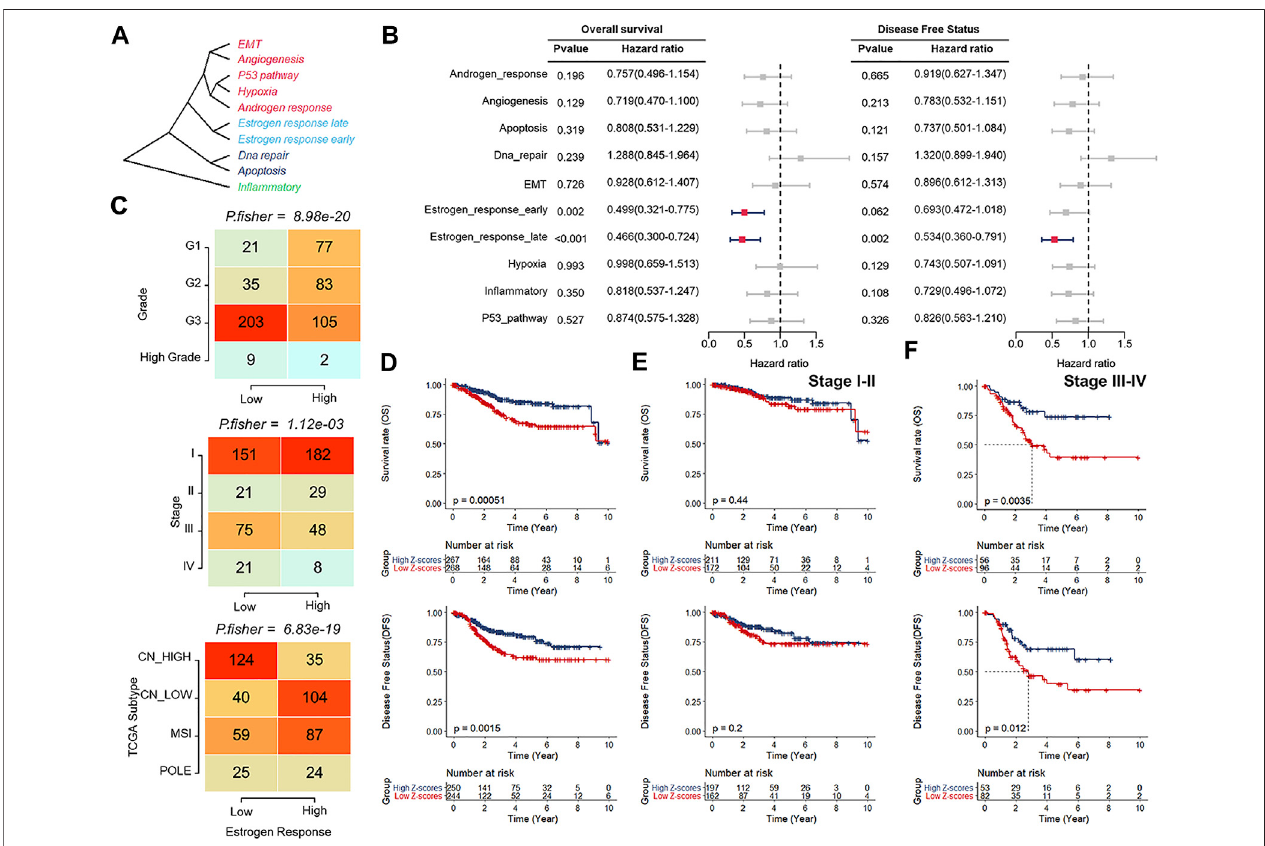
FIGURE 2 | Estrogen response pathway ssGSEA score was correlated with clinical features of patients with UCEC. (A) An unrooted clustering dendrogram depicting the distance between different hallmarks of cancer. (B) Univariate Cox regression analysis indicating cancer-related hallmarks that might affect UCEC progression. (C) Contingency tables demonstrating the correlation between the “ Estrogen response late ” ssGSEA score and pathological parameters, including tumor grade (upper), clinical stage (middle), and TCGA molecular subtypes (bottom). (D – F) Kaplan – Meier survival analyses of the low and high ssGSEA score groups patients at all stages (D) , stage I ~ II (E) , and stage III ~ IV (F)